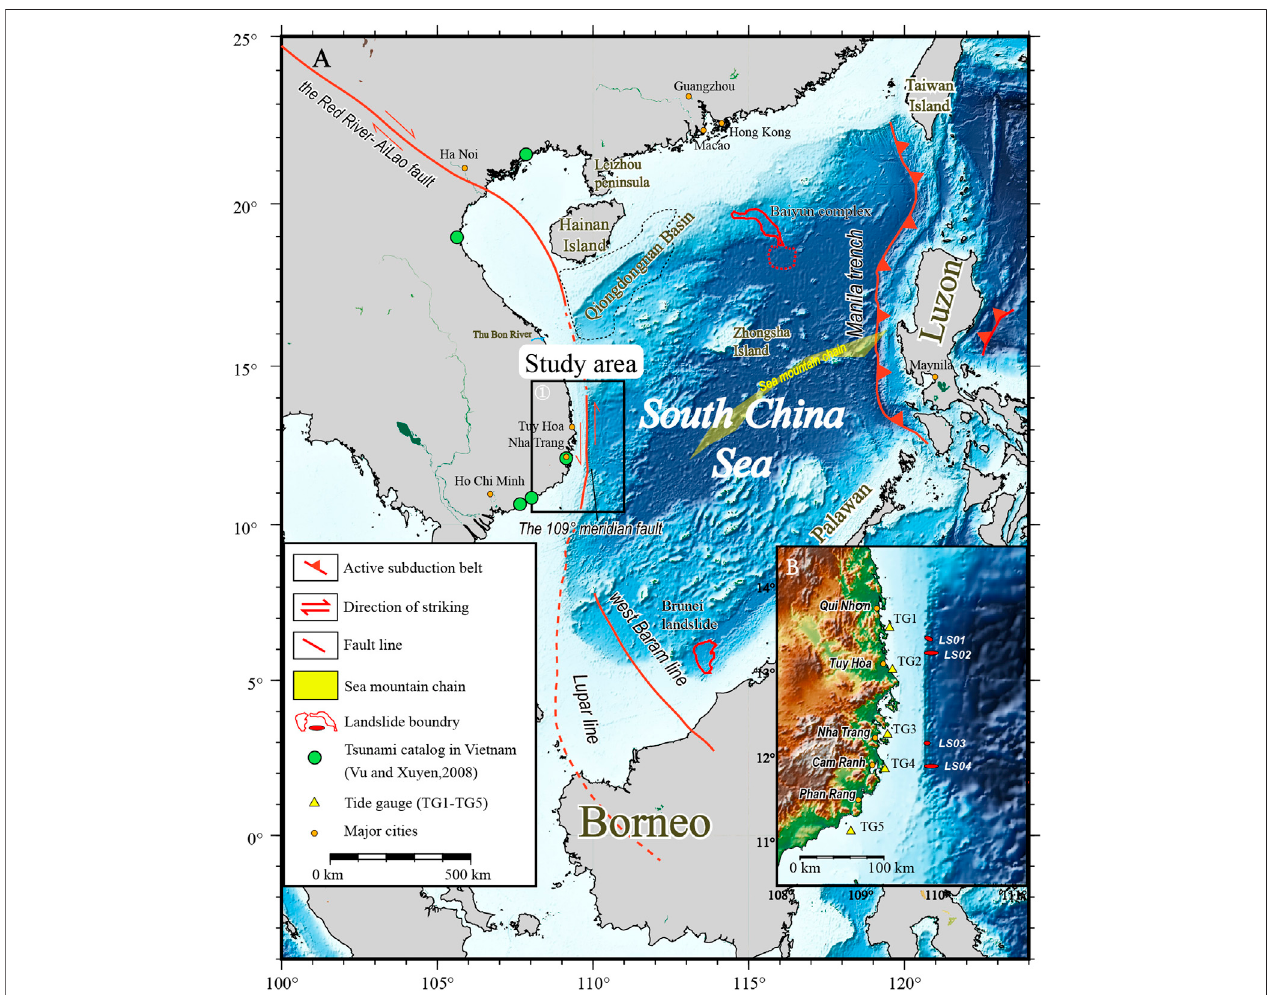
FIGURE 1 | The tectonic setting of the study area (A) . South China Sea (SCS), containing the major tectonic structure, geographic location and major cities. The blackrectangleindicatesthestudyareawherethe109 ° meridianfaultislocated.Theinset fi gure (B) showsthespatialdistributionsoftheselectedlandslides(redellipse), synthetic gauges (yellow triangles) and major coastal cities in